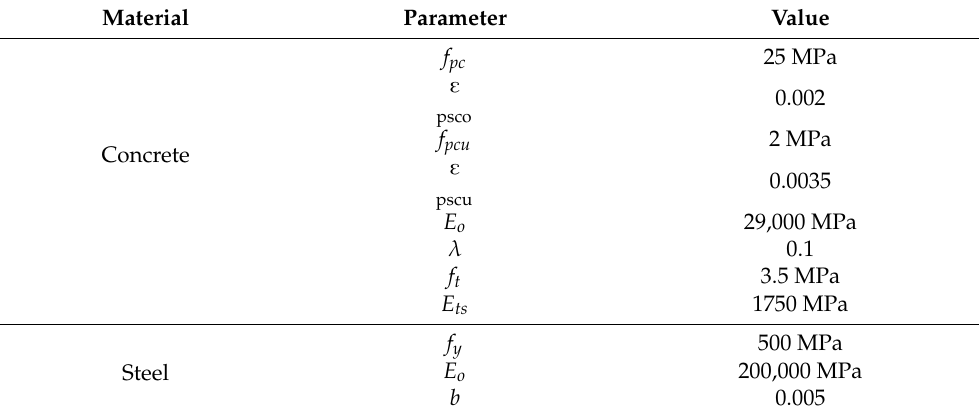
Table 4. Material properties for concrete and steel models used for modeling